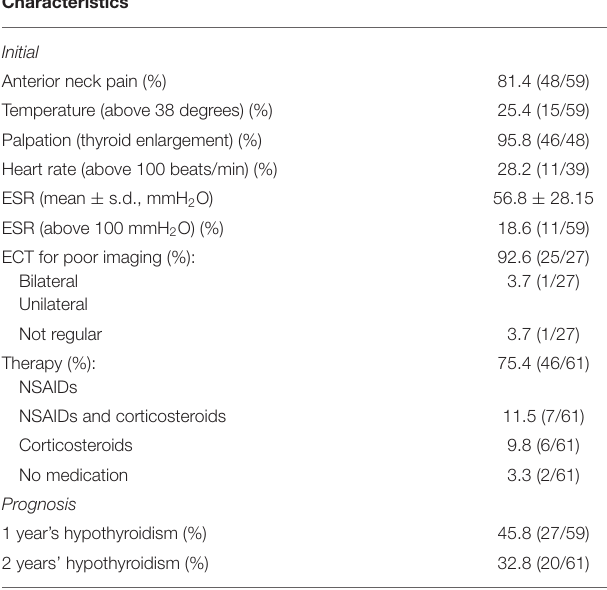
TABLE 2 | Clinical features of subacute thyroiditis